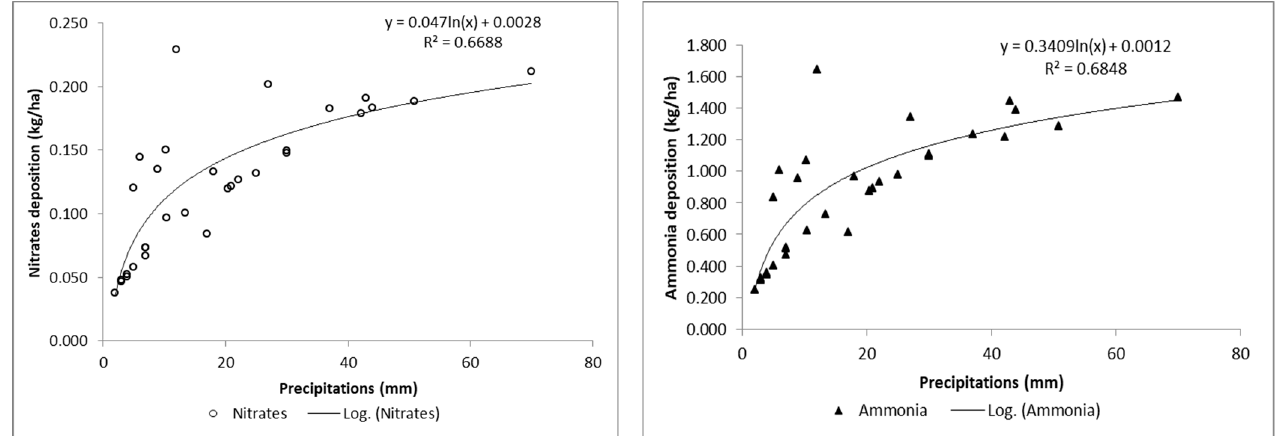
Figure 4. Nitrogen deposition for 31 rainfall events occurring in Targoviste city between April and November 2019 showing the computed and estimated by regression values.